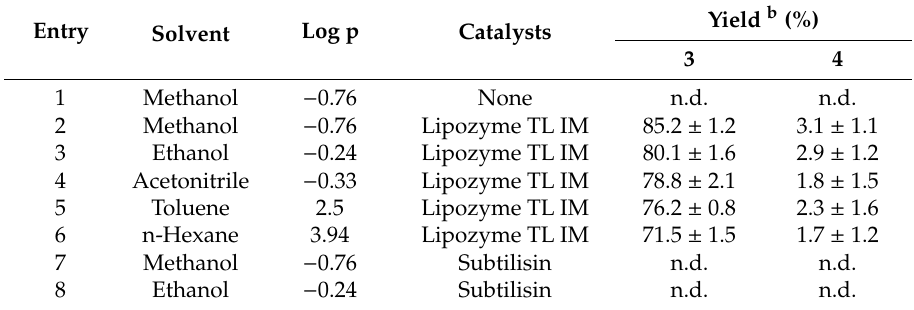
Table 1. E ff ect of reaction solvent and catalysts on the synthesis of β -amino alcohols under continuous-flow conditions a .